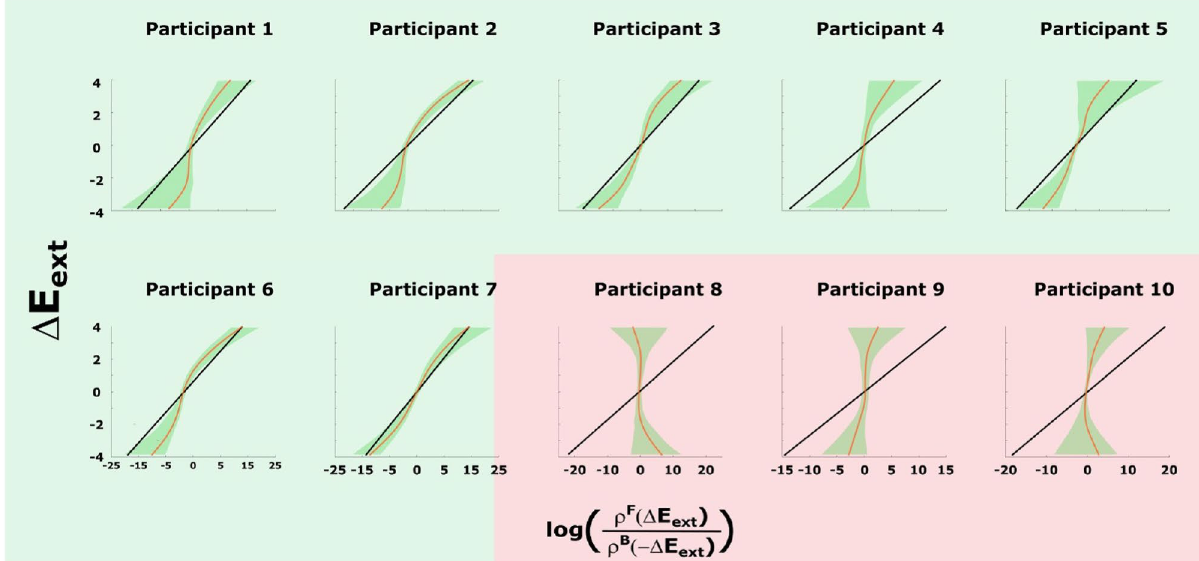
Figure 4. Experimental results for Crooks’ fluctuation theorem when the sensorimotor loss behaves as an exponential quadratic error (1). The black line is the theoretical prediction of Crooks’ fluctuation theorem (4) while the curves stand for the mean path after 1000 bootstraps of the observed driving error values. Participants that achieve at least 50% adaptation (c.f. Fig. 3) are shaded by a green background color. The shaded areas